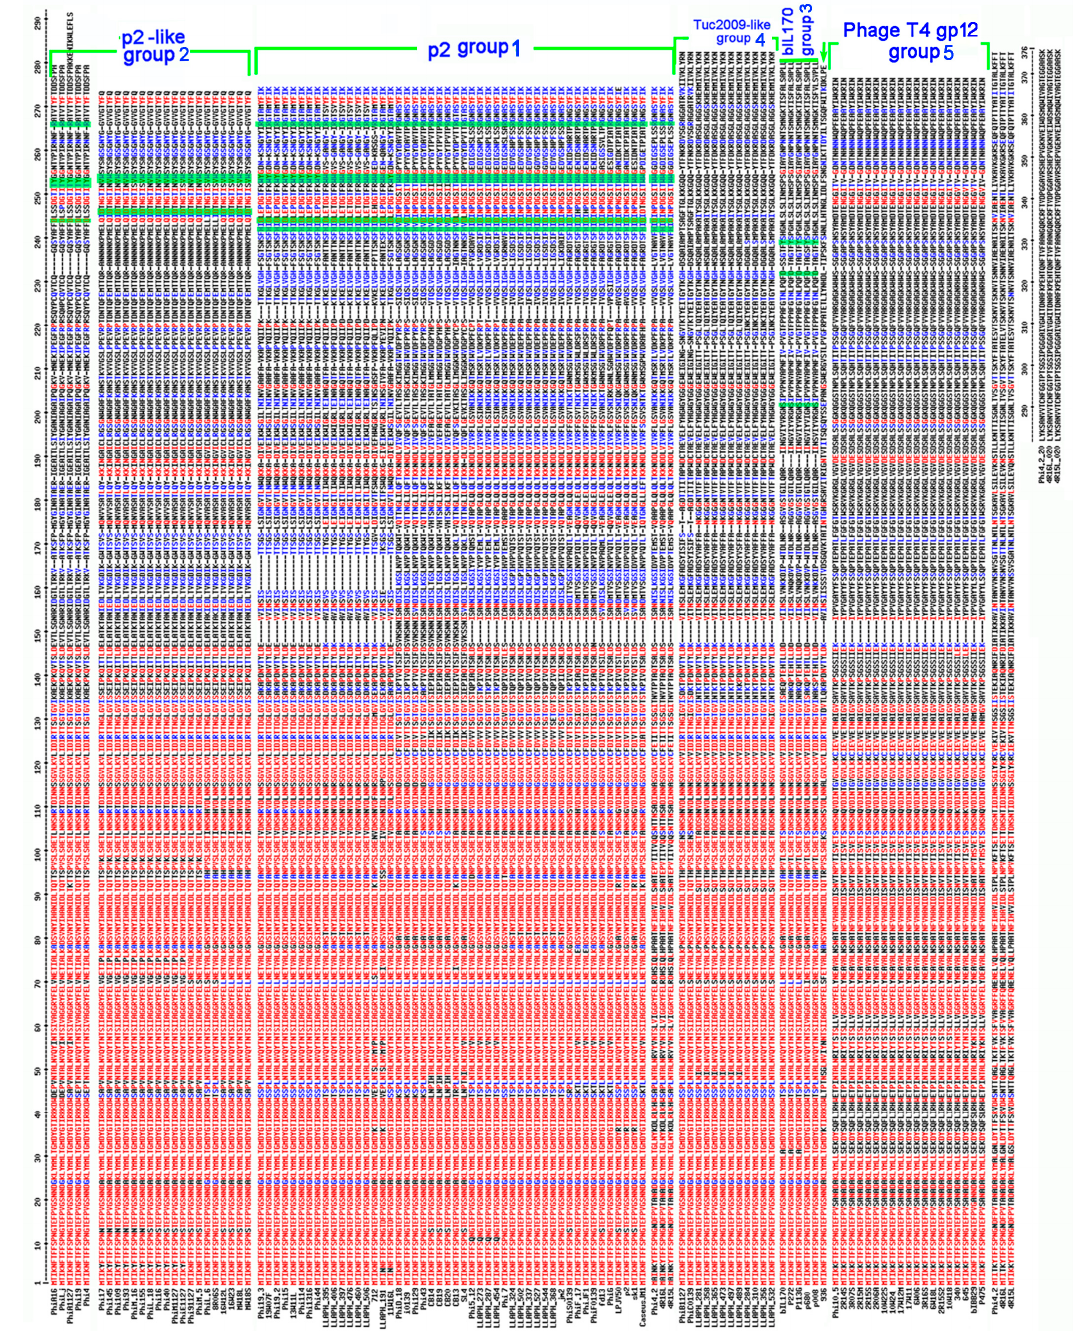
Figure 2. Sequence alignment of the RBP proteins. The various RBP groups, based on the predicted structure of the RBP head domain, are identified on the right of the alignment. The conserved amino acids are in red and the partially conserved in blue. Otherwise in black. The phage p2 4 essential amino-acids for receptor binding, Trp144, His232, Asp234 and Arg256, are conserved in the p2 class and only partly in the p2-like class. They are highlighted in green. This is not a cited image. Multalin is a program Performed with Multalin.